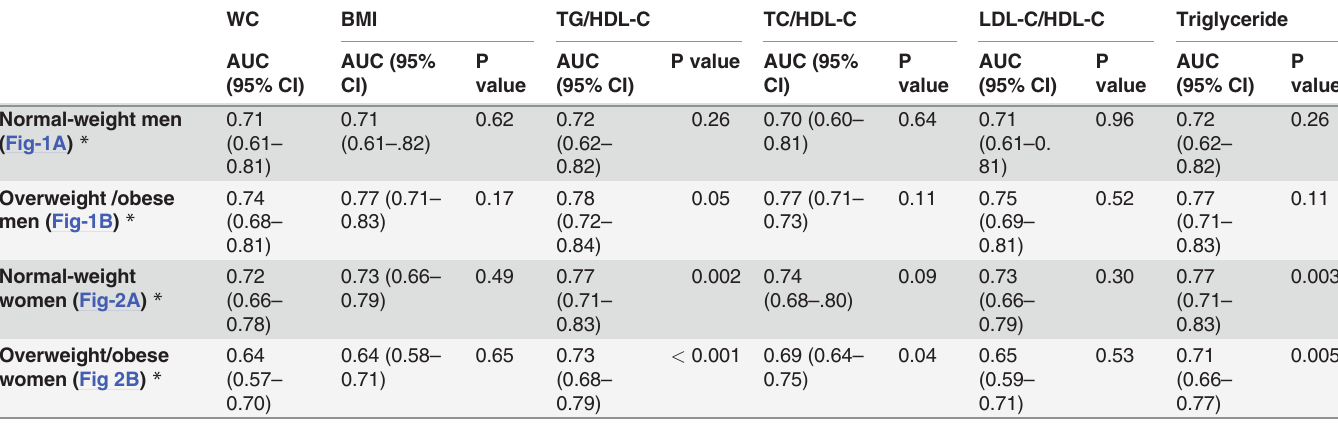
Table 3. Area under the receiver operating characteristic curves a for potential markers of